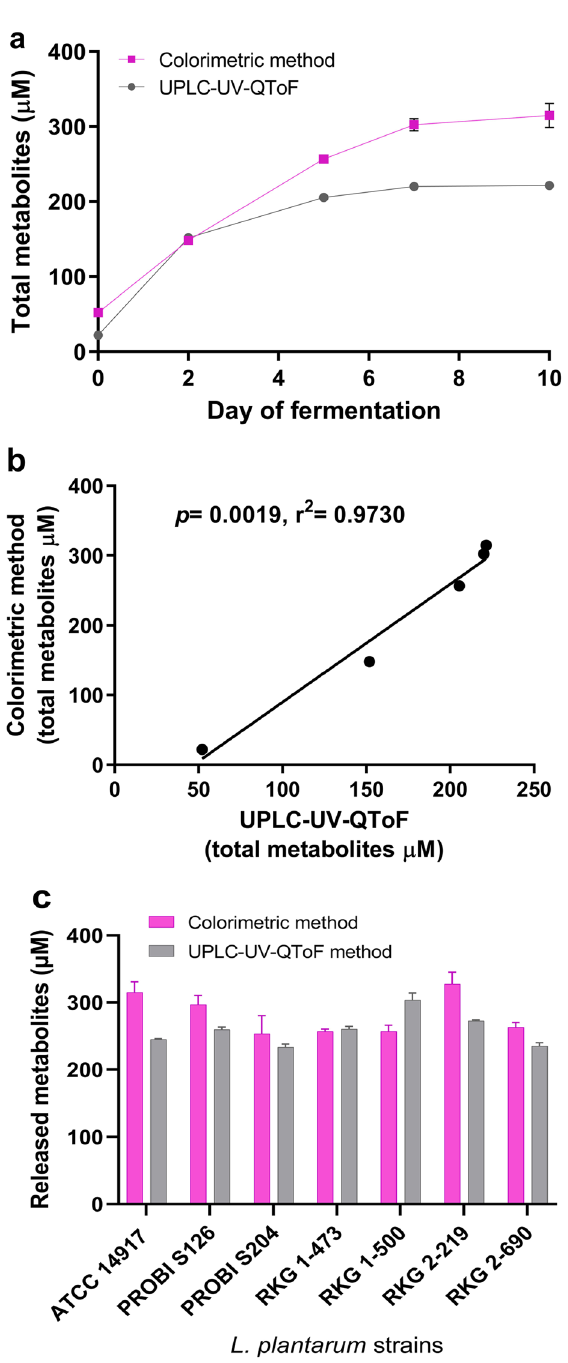
Figure 3. Spectrophotometric method to screen TanA activity in L. plantarum . ( a ) Total metabolites (gallic acid + pyrogallol) released by a TanA+ strain (ATCC 14917) throughout a tannic acid-rich medium fermentation. In pink, the results obtained by the proposed colorimetric method; in gray, the ones obtained by UPLC-UV-QToF. ( b ) Pearson correlation between the colorimetric and the UPLC-UV-QToF method. ( c ) Total released metabolites by the six selected L. plantarum strains after 10 d of fermentation. In pink, the results of the colorimetric method; in gray, the ones of